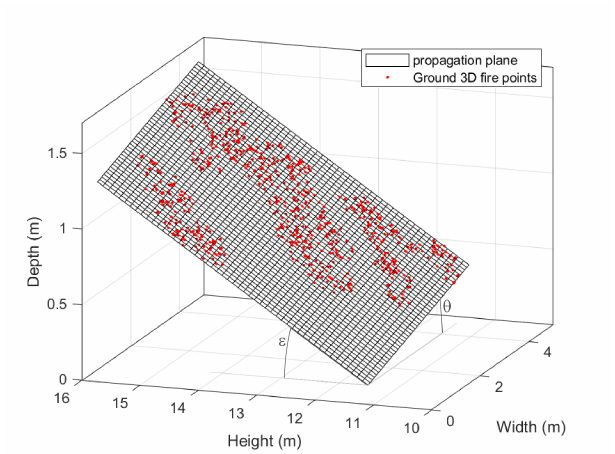
Figure 6. Example of the propagation plane obtained from the lower 3D points of a spreading fire.